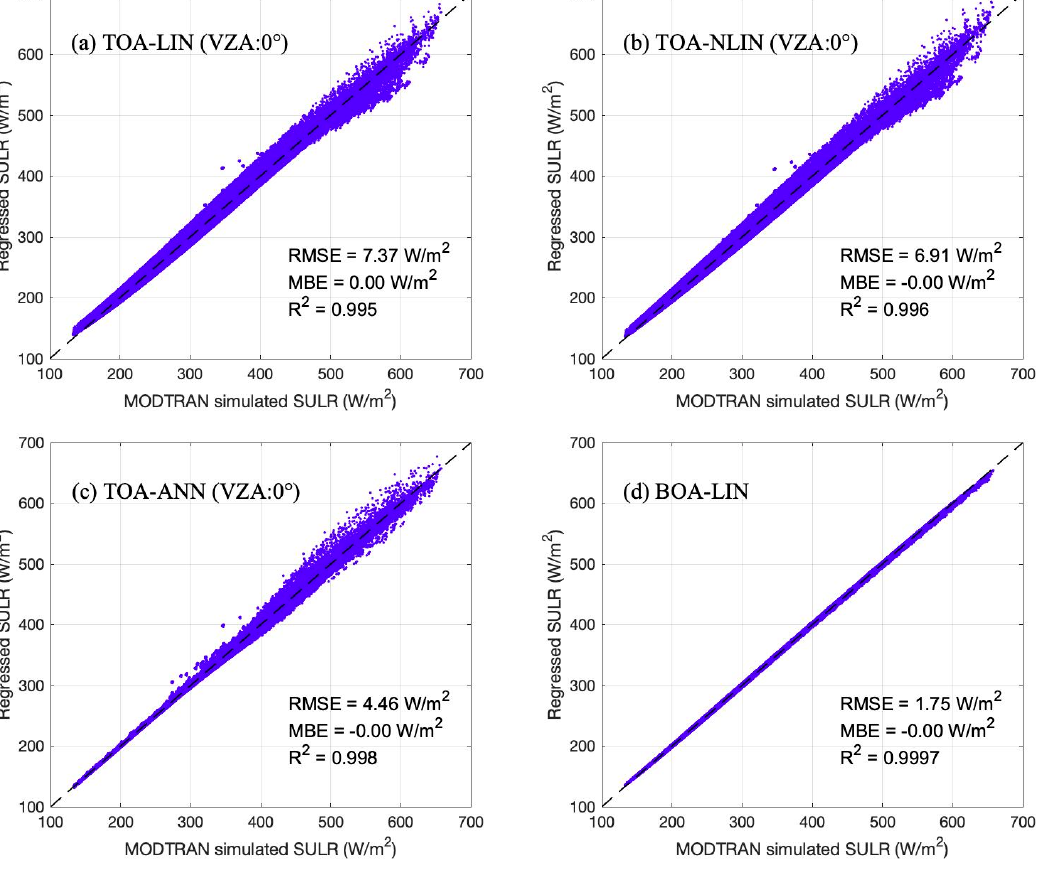
Figure 3. Scatterplots between MODTRAN simulated SULR and estimated SULR of four hybrid methods ( a – c ), TOA-LIN, TOA-NLIN, and TOA-ANN methods with simulation data of VZA = 0 ◦ . ( d ) BOA-LIN method with all VZA values.